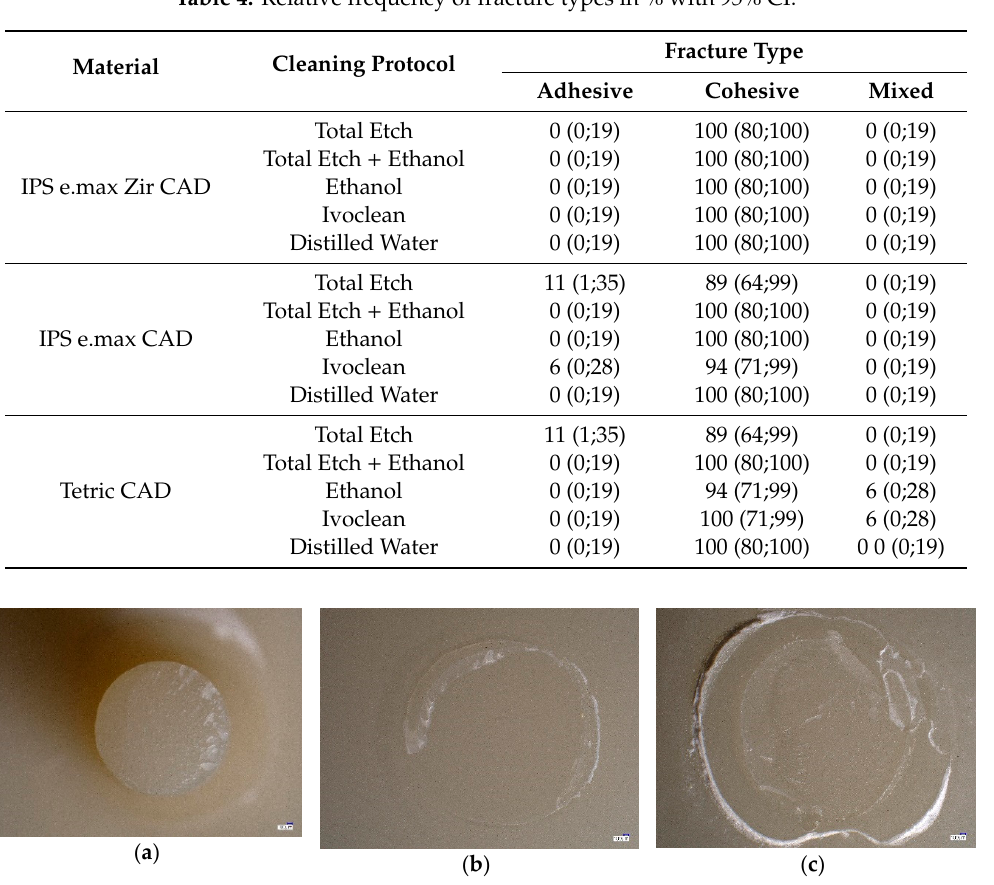
Figure 4. Overview of occurred fracture types according to the definition of ( a ) adhesive, ( b ) cohesive and ( c )